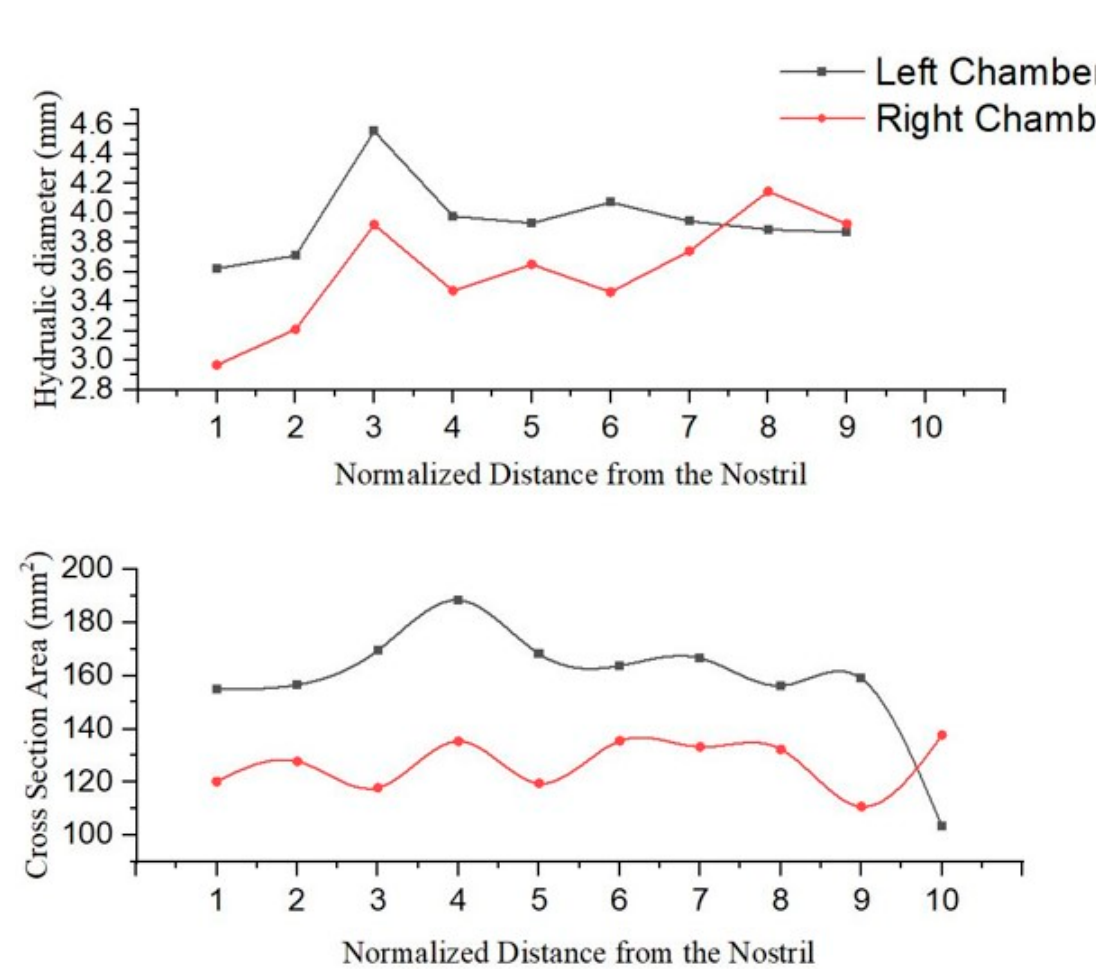
Figure 4. Hydraulic diameter and cross-section area as function of distance from the nostrils.